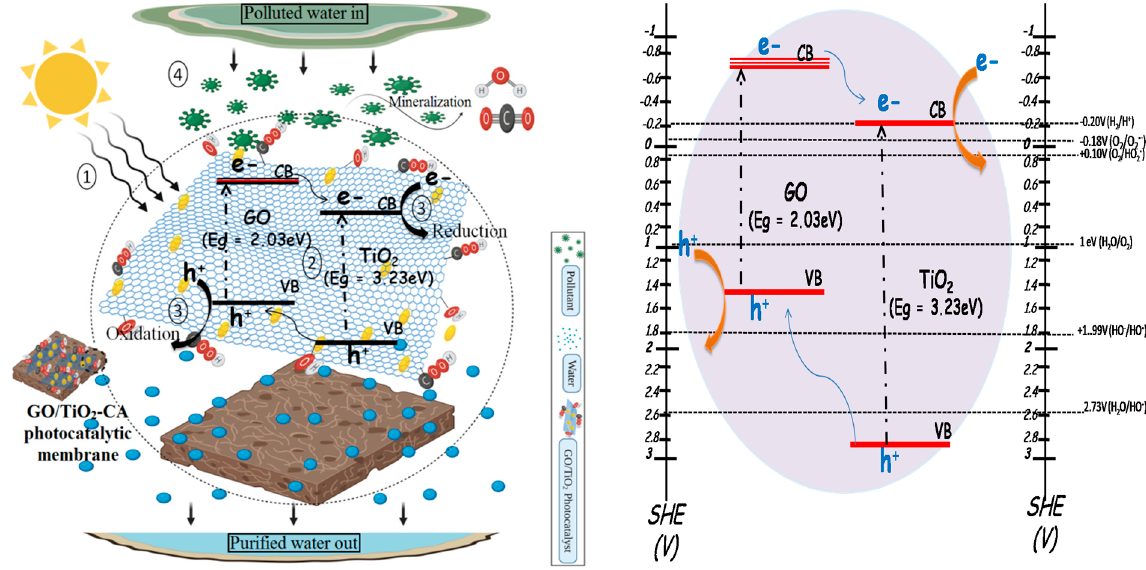
Figure 12. Possible mechanism of GO/TiO 2 -CA membrane for wastewater treatment.